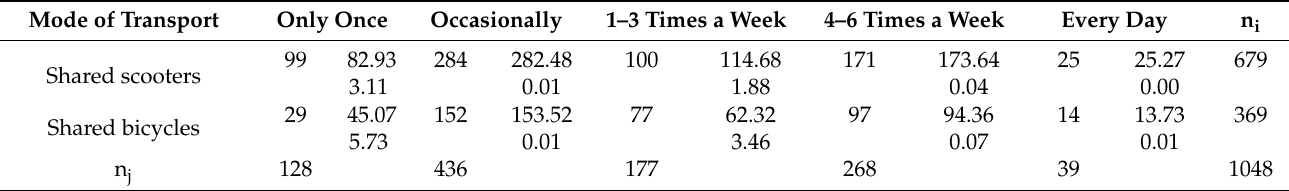
Table 2. Dependence of frequency of use on the mode of transport.